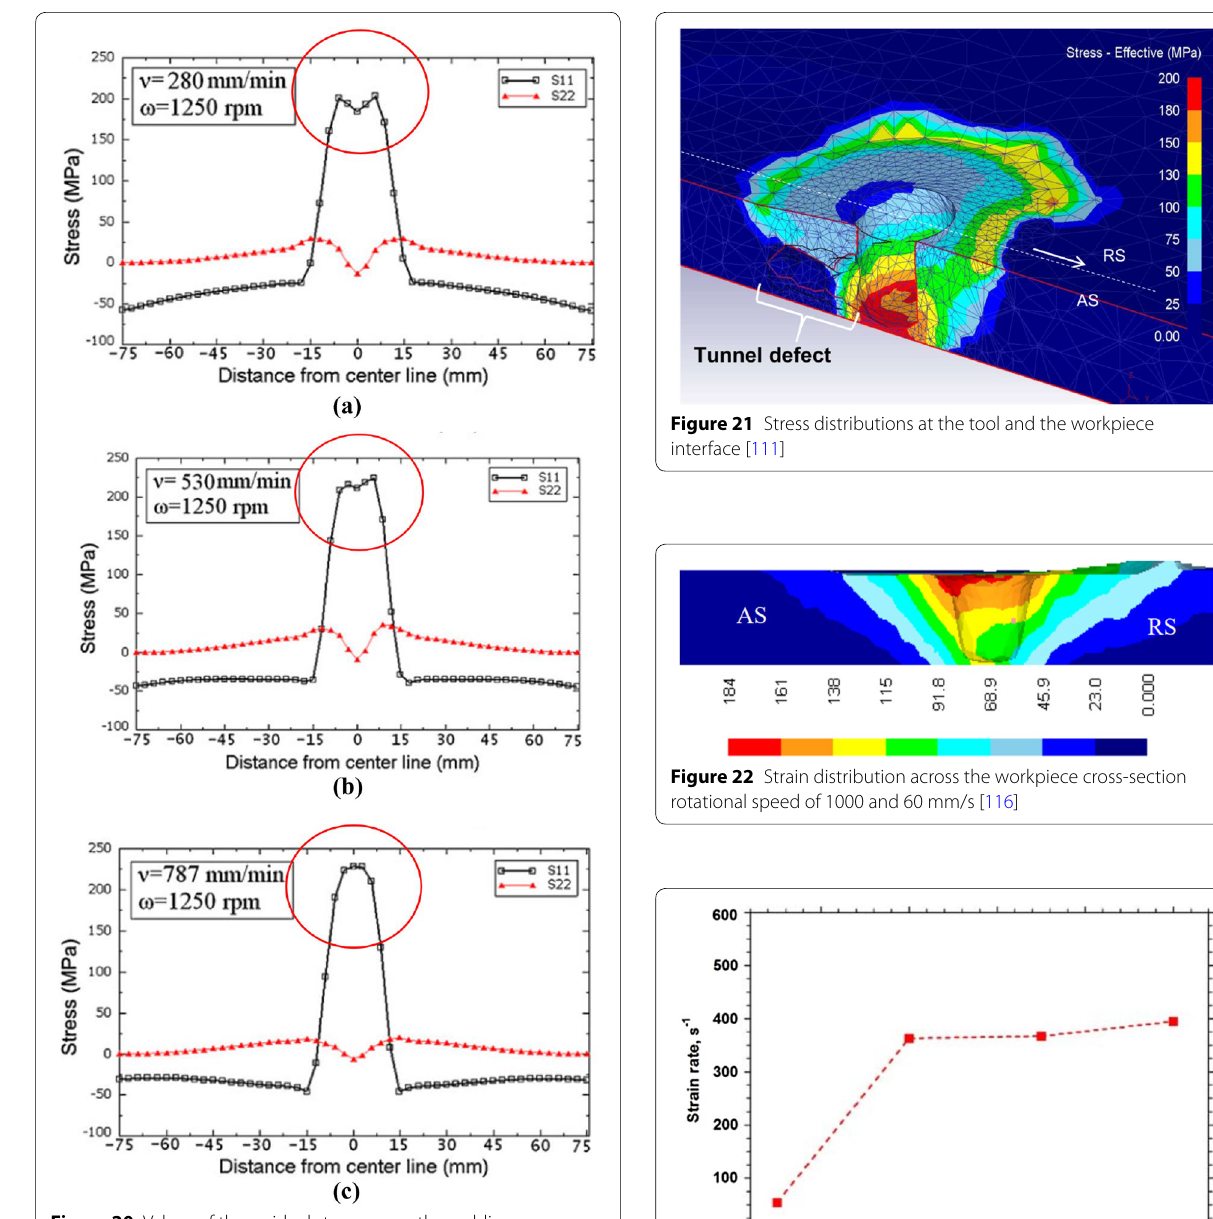
Figure 20 Values of the residual stress across the welding cross-section: ( a ) the transverse velocity of 280 mm/min and the rotational speed of 1250 r/min, ( b ) the transverse velocity of 530 mm/ min and the rotational speed of 1250 r/min, ( c ) the transverse velocity of 787 mm/min and the rotational speed of 1250 r/min [115]